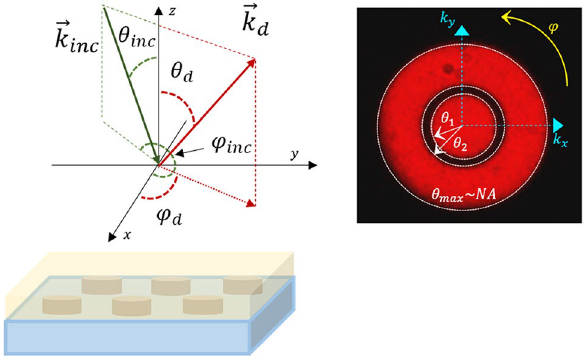
Figure 7. Scheme of the diffracted wave-vector and the typical recorded angular